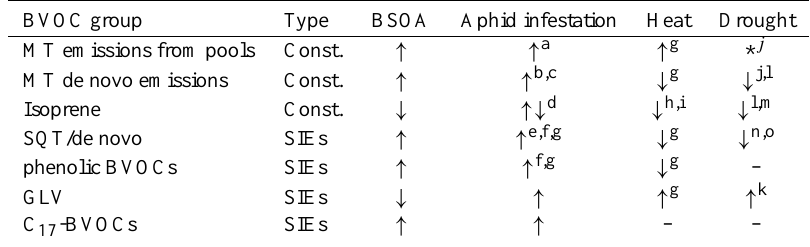
Table 5. BVOC emissions used for estimating impacts of stress-induced emissions on BSOA formation. Type: Const = constitutive emis- sions, SIEs = stress-induced emissions. The BSOA column gives the effect of emissions on BSOA assuming increase in emission strengths of the respective BVOC group. The arrows in columns biotic, heat and drought indicate expected trends for the emissions of the respective BVOC group in case of biotic, heat, and drought stress, respectively. BVOC group Type BSOA Aphid infestation Heat Drought MT emissions from pools Const. ↑ ↑ a ↑ g * j MT de novo emissions Const. ↑ ↑ b,c ↓ g ↓ j,l Isoprene Const. ↓ ↑↓ d ↓ h,i ↓ l,m SQT/de novo SIEs ↑ ↑ e,f,g ↓ g ↓ n,o phenolic BVOCs SIEs ↑ ↑ f,g ↓ g – GLV SIEs ↓ ↑ ↑ g ↑ k C 17 -BVOCs SIEs ↑ ↑ –